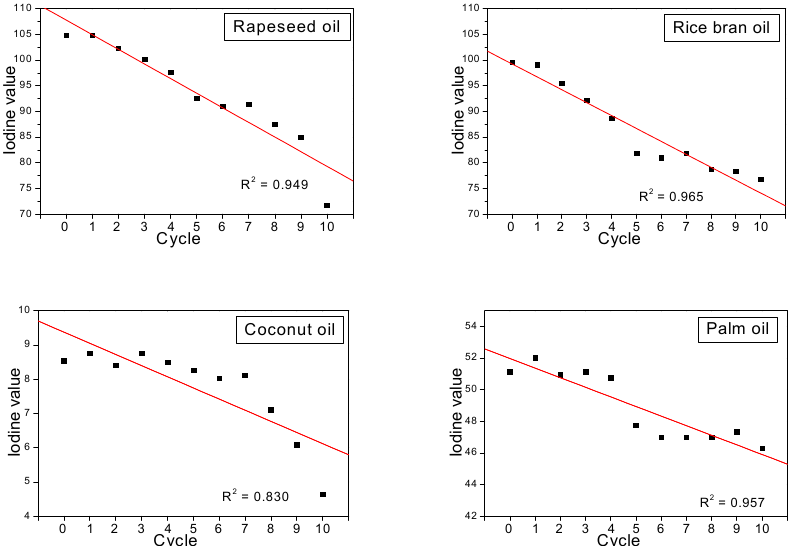
Figure 1. Dependence of the iodine values on heating time. The regression coefficients are from − 2.89 (rapeseed oil) to − 0.32 (coconut oil).